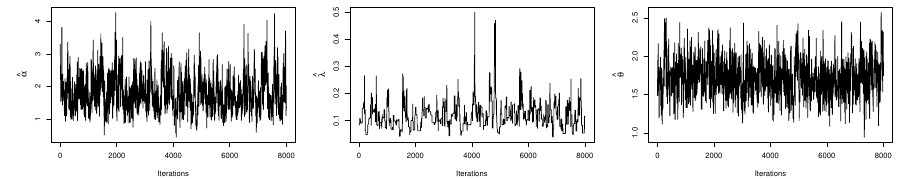
Figure 9. Plots of the iteration obtained from the BE for the precipitation data.